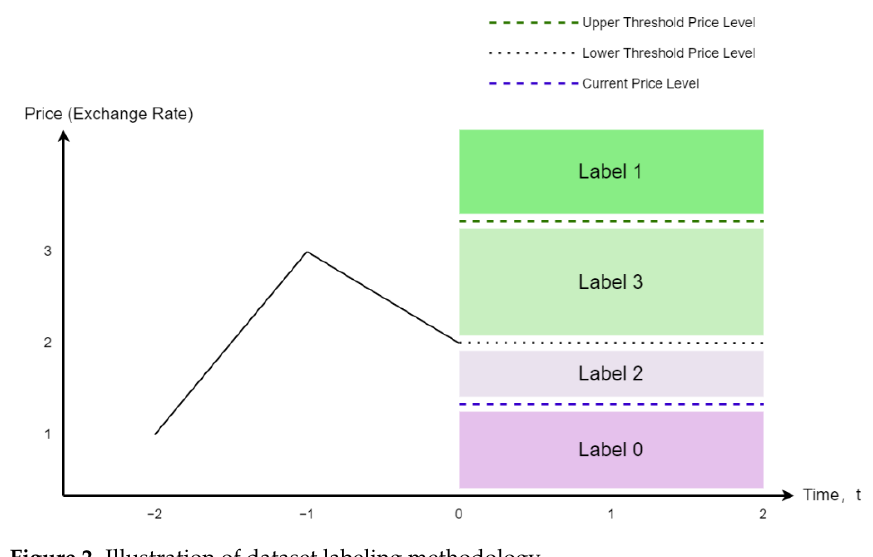
Figure 2. Illustration of dataset labeling methodology.